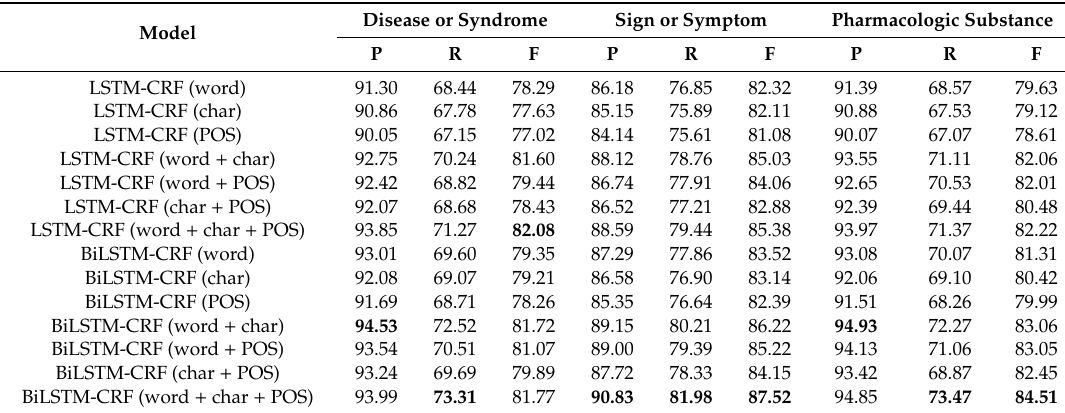
Table 7. The predictive performance for di ff erent models on the testing set.